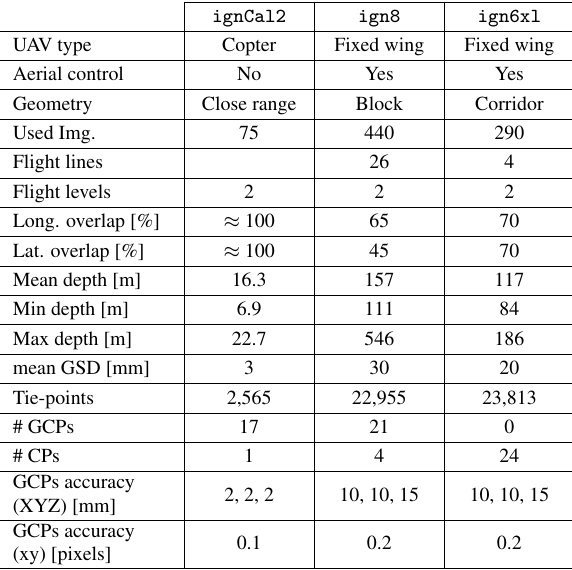
Table 7. Flights details of open data.